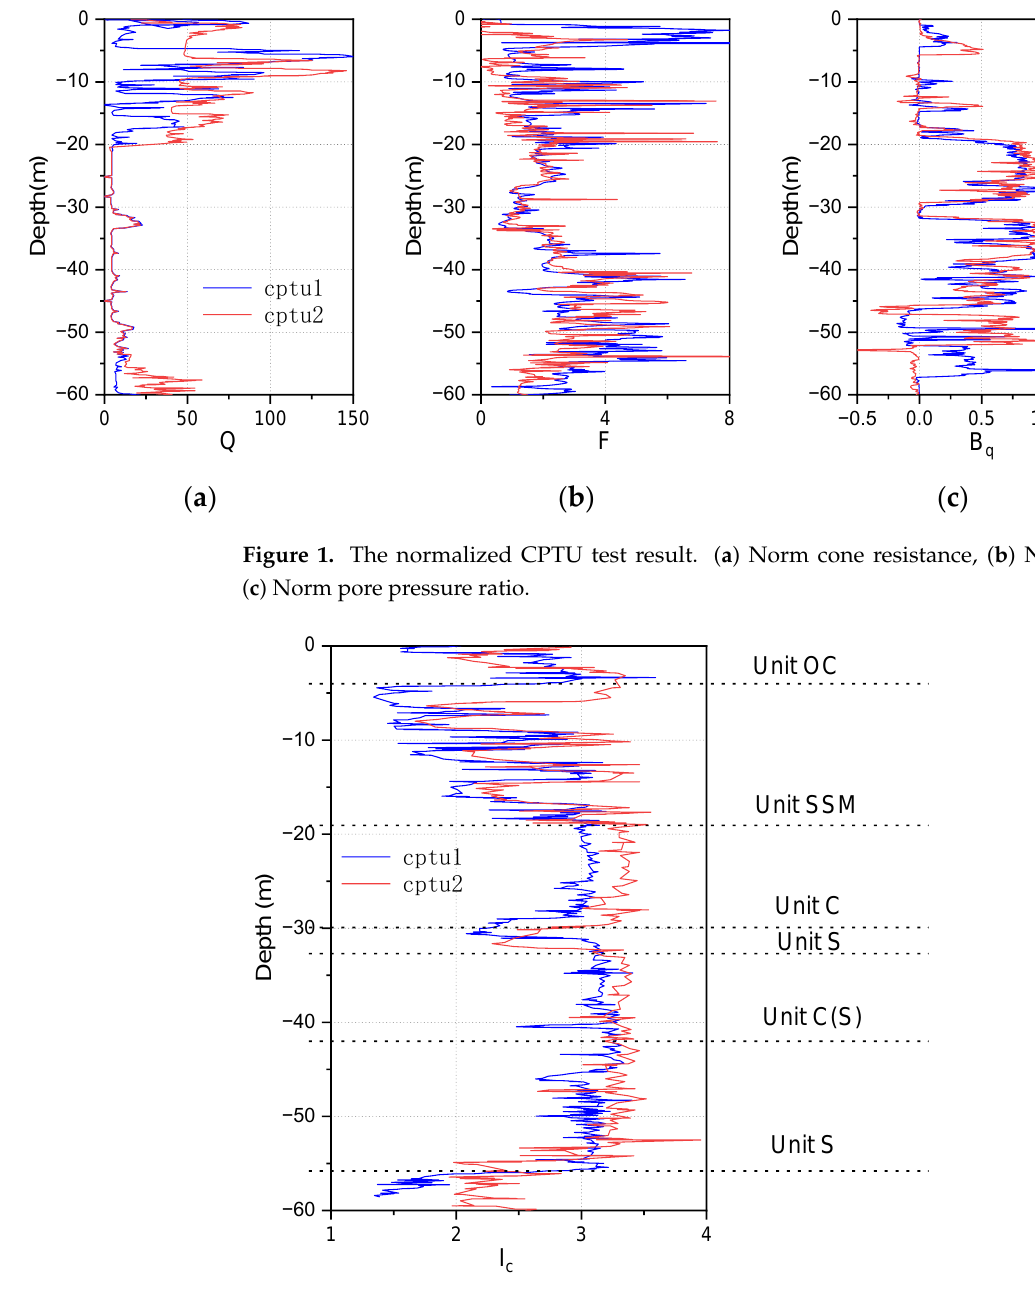
Figure 2. Soil Figure 2. Soil classification. Table 1. Geotechnical design parameters.